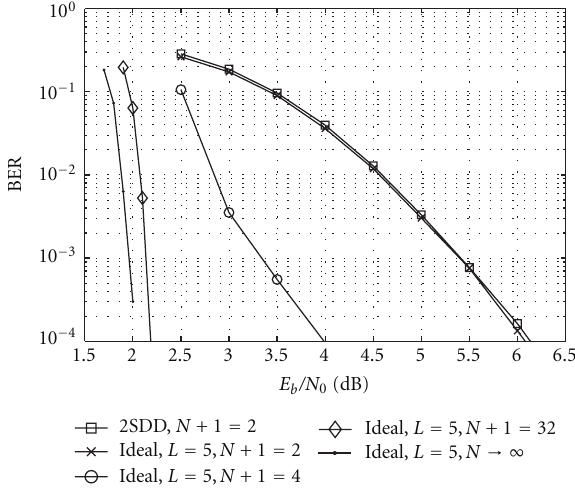
Figure 10: Bit-error performance for the Peleg method for di ff erent values of N and L = 5